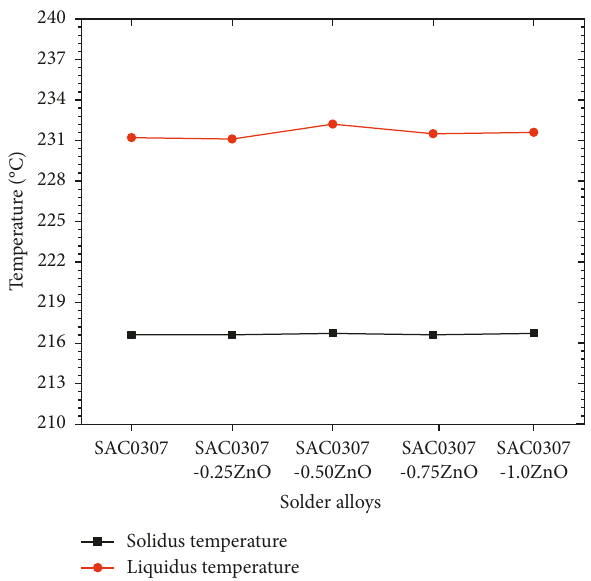
Figure 2: The solidus and liquidus temperatures of the SAC0307- xZnO solders at variable nano-ZnO